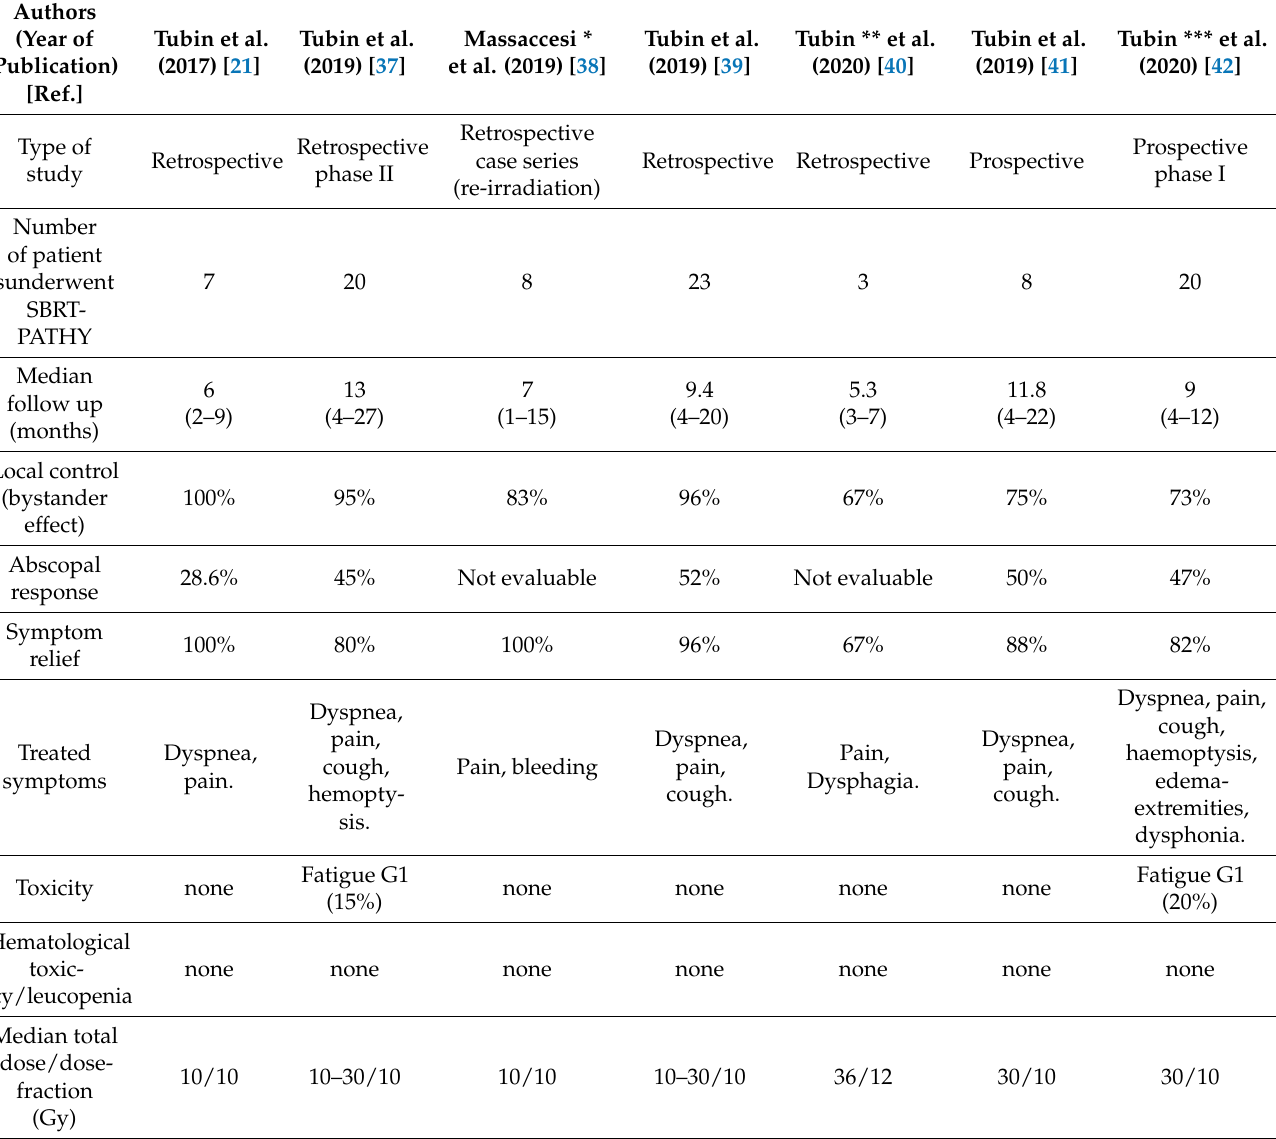
Table 1. Treatment characteristics of the selected